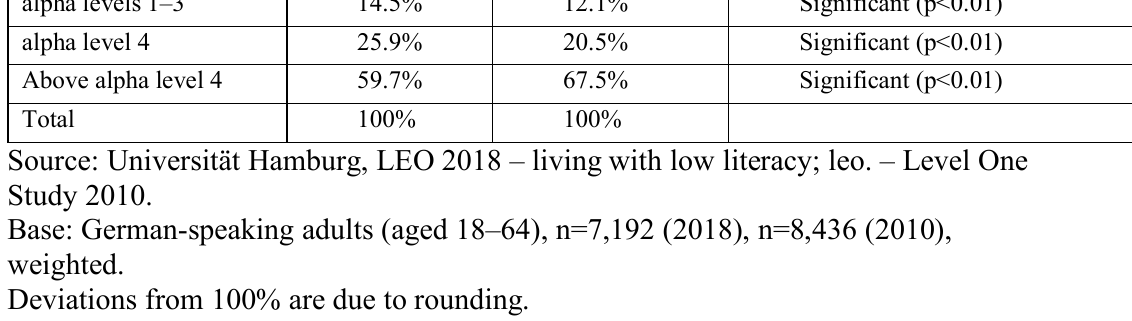
Table 2: German-speaking adult population (aged 18–64) classified by Alpha Level, comparing 2010 and 2018 Alpha Level 2010 percentage 2018 percentage Significance of change alpha level 1 0.6% alpha level 2 alpha level 3 alpha levels 1–3 Above alpha level 4 Total